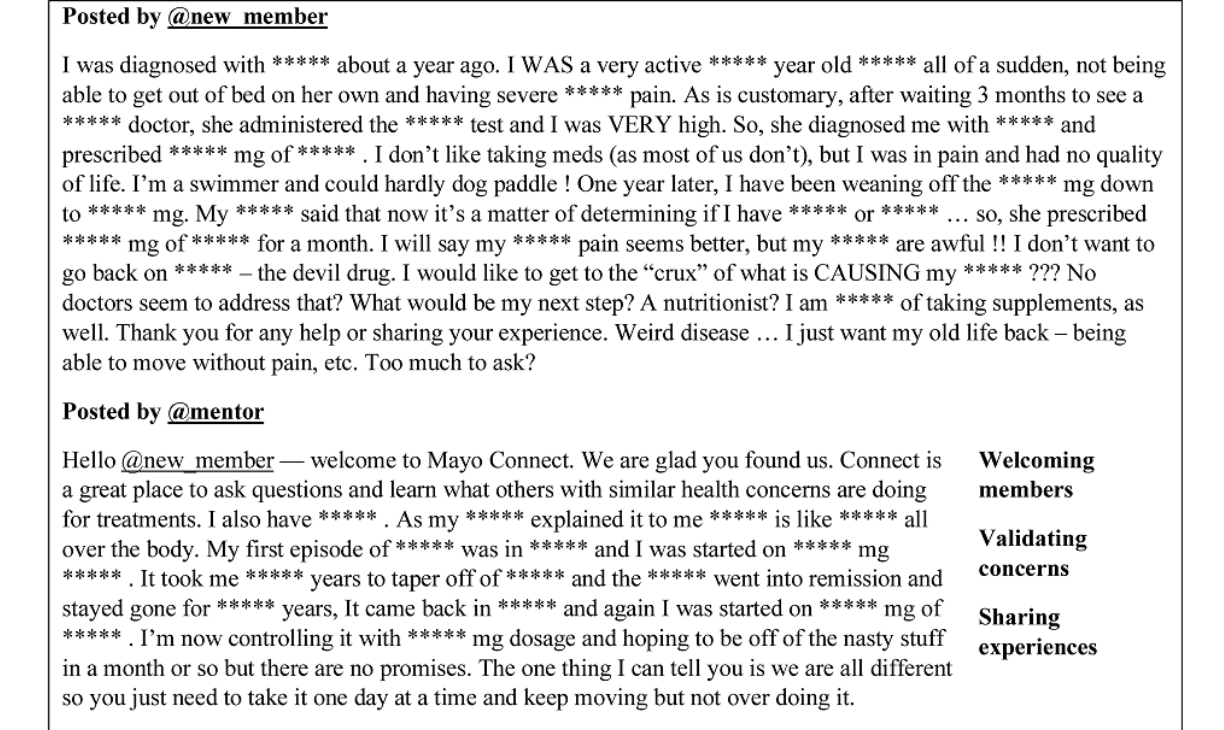
Figure 1. Moderation practices employed in one example